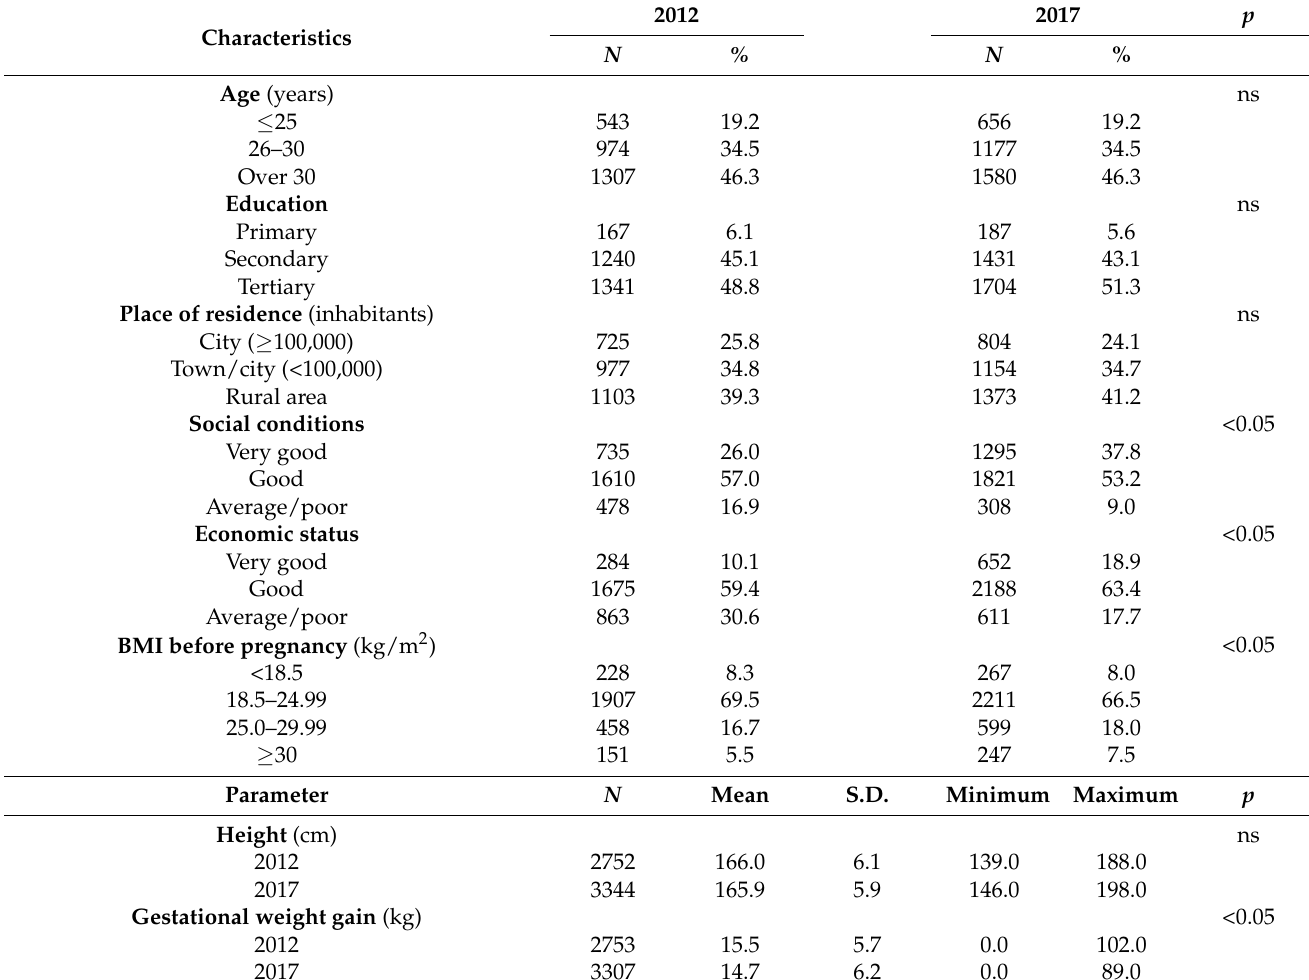
Table 1. Characteristics of the study